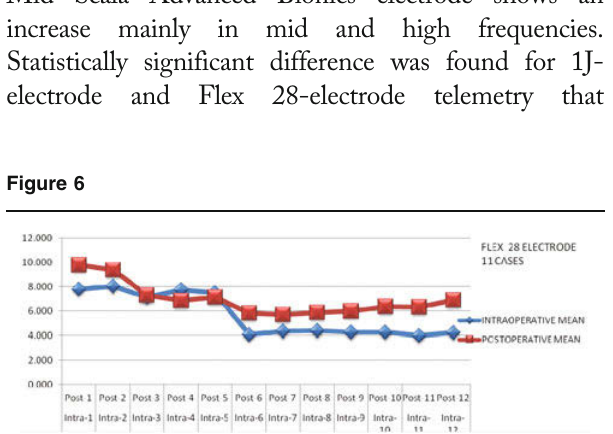
Mean of active electrode impedance for intraoperative and postop- erative results regarding different types of electrodes used in this